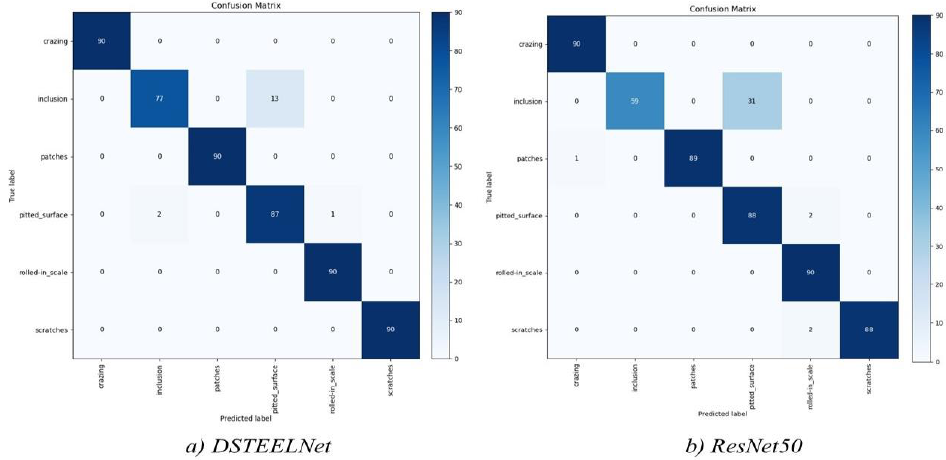
Figure 9. Training and validation accuracy of DSTEELNet on GNEU.